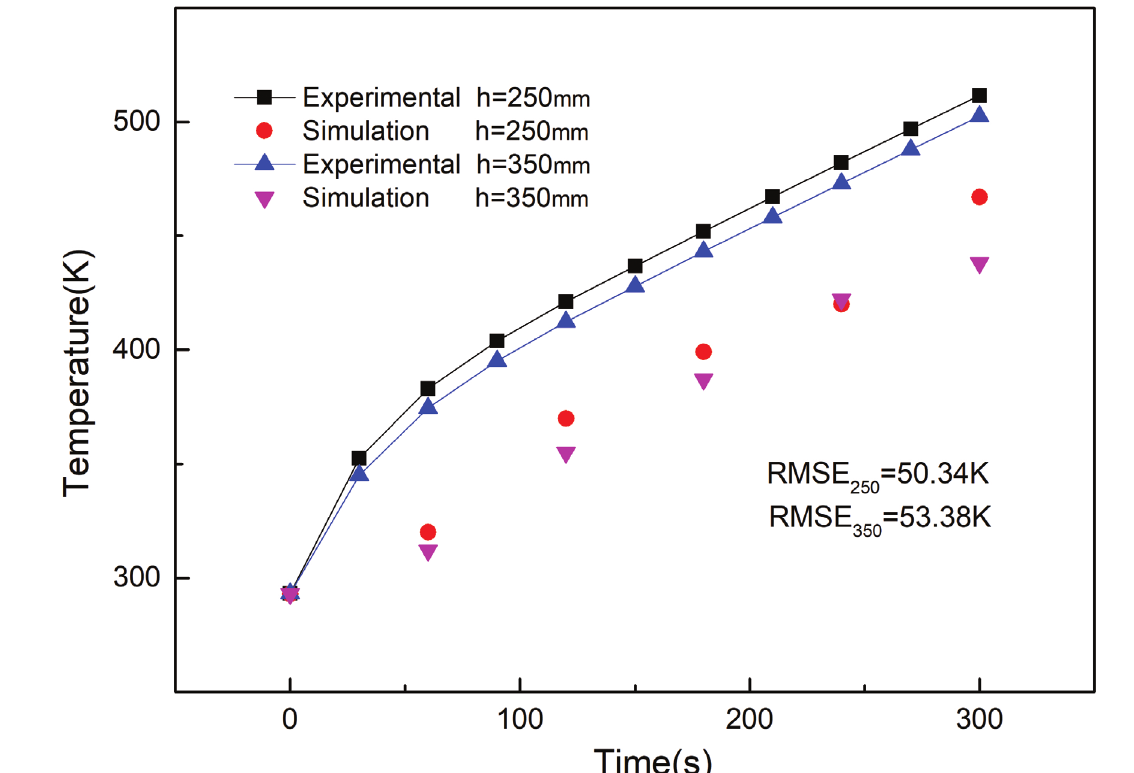
Figure 3: Comparison of the experimental and simulated temperature evolution of Y-TZP, h = 250 mm and h = 350